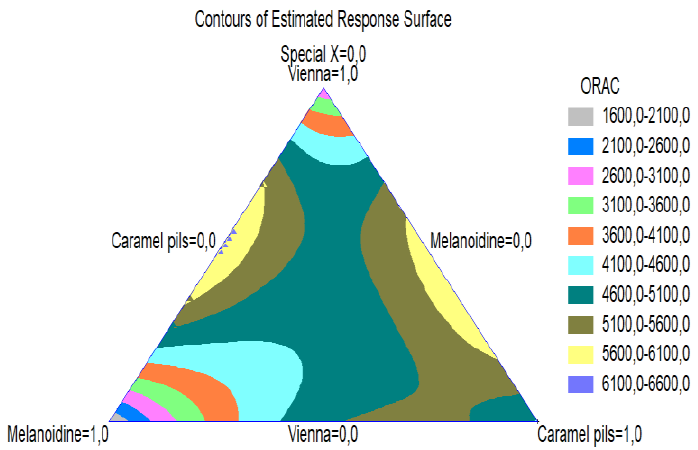
Figure 8. Effect of mixture composition on the antioxidant activity, measured by ORAC method. (the “ , ” character represents a decimal point).